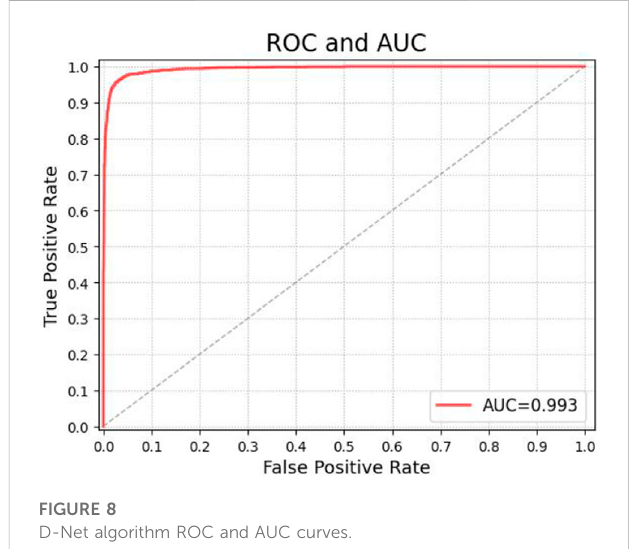
FIGURE 8 D-Net algorithm ROC and AUC curves.